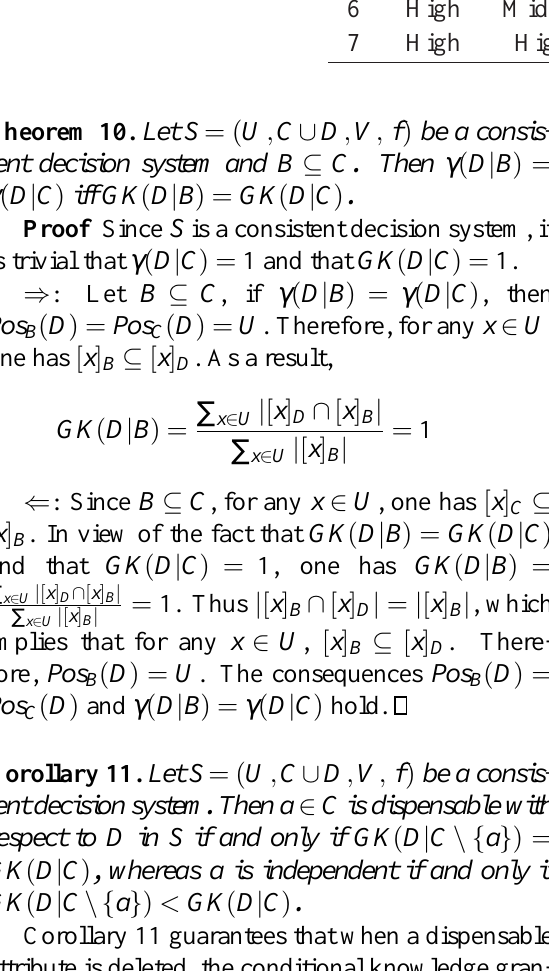
Algorithm 13 Forward greedy search algorithm of feature selection based on conditional